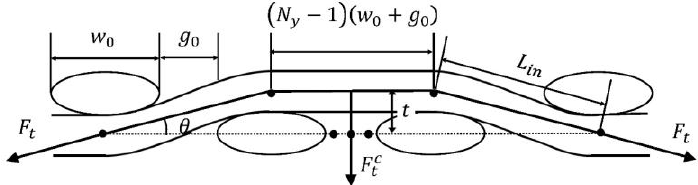
Figure 5. The contact force produced by the tension force of a yarn (plain-woven fabric).